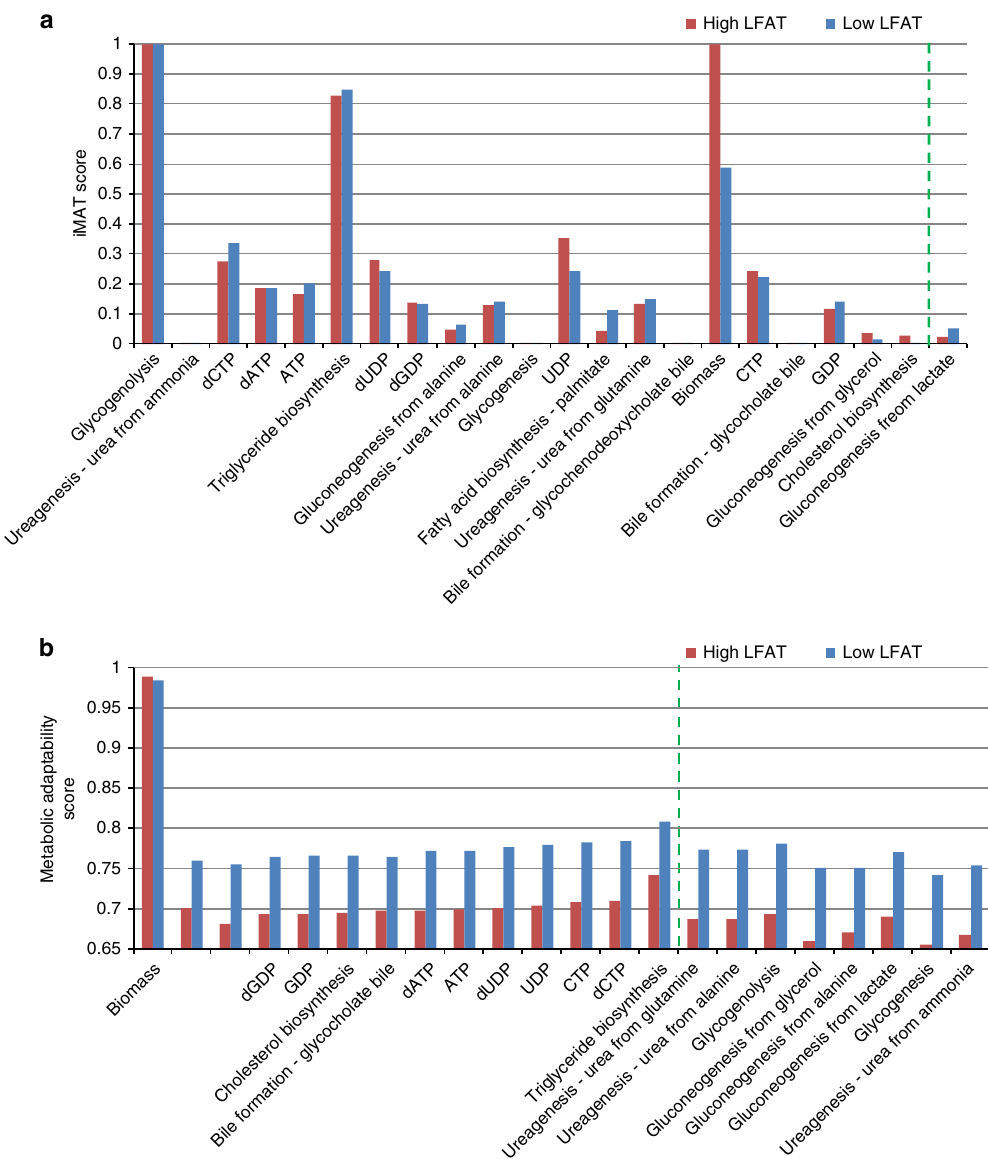
Figure 2 | GSMM analysis reveals reduced metabolic adaptability in NAFLD. Median functionality scores ( y axis) obtained in the high (red) and low (blue) fat groups according to: ( a ) iMATand ( b ) metabolic adaptability analysis (MPA). The functions are ordered according to their P -values (Wilcoxon signed-ranksum test), from largest to smallest, such that the ones that are on the right side of the dashed line obtained P -values that are less than 0.1. NATURE COMMUNICATIONS|7:8994|DOI: